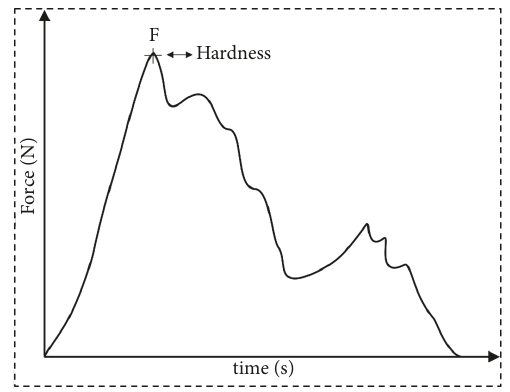
Figure 2: Typical curve of force (N) versus time (s) showing the maximum compression force used for describing the snack